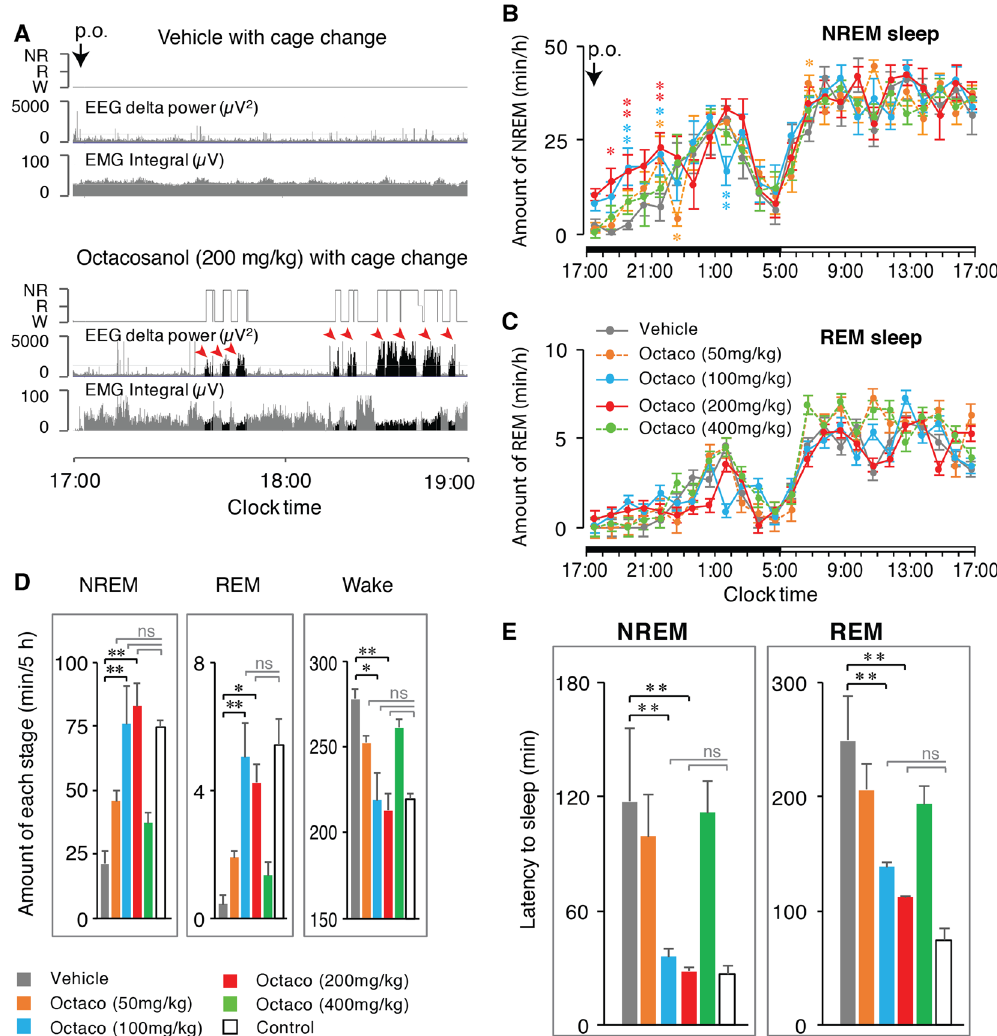
Figure 2. Oral administration of octacosanol dose-dependently increased NREM sleep and decreased wakefulness in mice. ( A ) Typical examples of EEG delta power (0.5–4 Hz), EMG integral, and hypnograms of a mouse after p . o . administration of vehicle or octacosanol. Hypnograms represent concatenated 10-sec epochs of EEG/EMG activity, scored as wake, REM, and NREM sleep. Two hours after p . o . administration are shown. Wake, REM are shown in gray while NREM sleep shown in black. Arrowheads shows increase in delta power. ( B , C ) Hourly plots of NREM and REM sleep in wild-type mice after oral administration of vehicle (gray circles) and various doses of octacosanol (color circles). Black and white horizontal bars indicate 12-h dark and 12-h light period. Data presented as mean ± SEM; n = 5; * p ≤ 0.05, ** p ≤ 0.01, vs vehicle, by using two-way ANOVA followed by Least Square Difference (LSD) post hoc test. ( D ) Total amount of wake, REM, and NREM sleep over 5 h during dark period, ( E ) changes in NREM and REM sleep onset latency after vehicle (gray bar) and various doses of octacosanol (color bars) administration. Open bars ( D , E ) represent control (whereby vehicle was administered while animals remained in their home cages). Data presented as mean ± SEM; n = 5–8; * p ≤ 0.05, ** p ≤ 0.01, vs vehicle, by using one-way ANOVA followed by Scheffe post hoc test. Octaco: octacosanol, ns: not